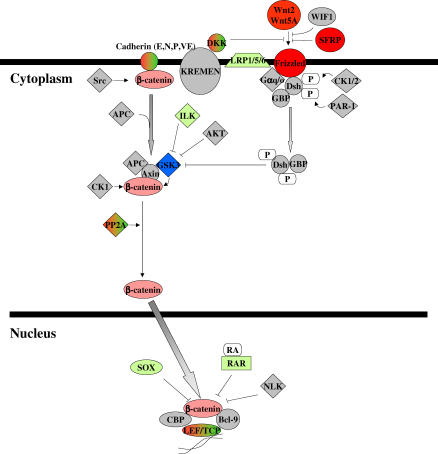
Changes in the Expression of Genes Known to be Involved in the Canonical Wnt PathwayThe figure was generated using Ingenuity Pathways Analysis (Ingenuity Systems, http://www.ingenuity.com/). Increased genes are in increasing shades of red, decreased are in increasing shades of green. Combined red and green is when different members are changed in different directions.